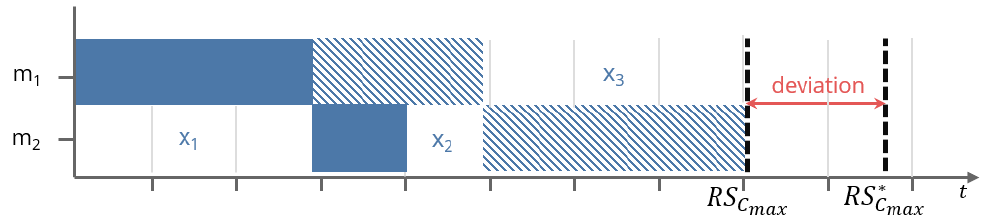
Figure 2. Exemplary schedule with two jobs and two machines (Gantt